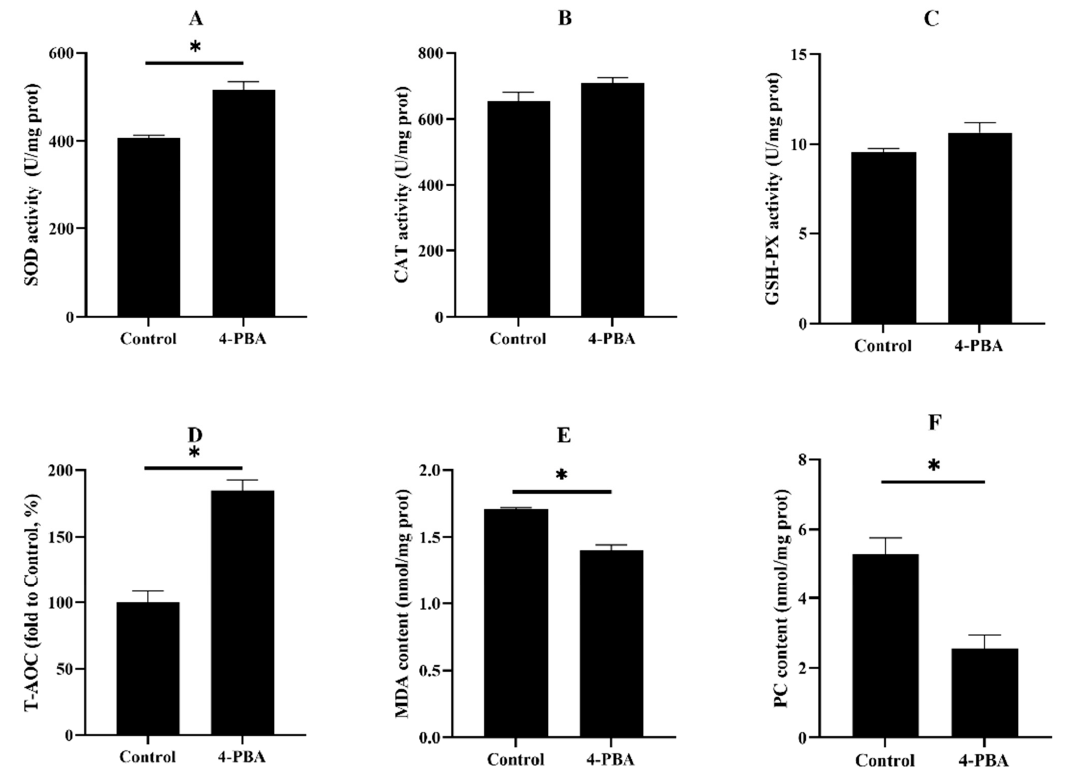
Figure 7. The activities of superoxide dismutase (SOD: ( A )), catalase (CAT: ( B )), glutathione peroxidase (GSH-PX ( C )), the level of total antioxidant capacity (T-AOC: ( D )), and the content of malondialdehyde (MDA: ( E )) and protein carbonylation (PC: ( F )) in the livers of L. maculatus after two weeks of being fed the test diets and 48 h of ammonia nitrogen exposure. All values are exhibited as mean ± SE. The values with different superscript (*) are significantly different at p < 0.05 (Student’s t -test).